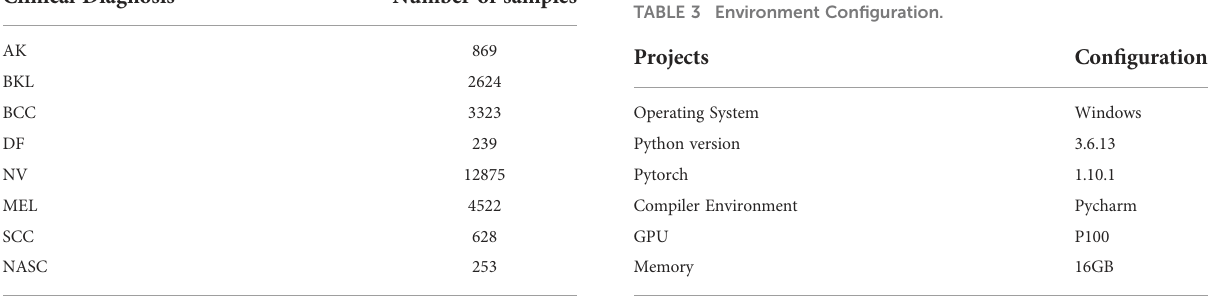
TABLE 3 Environment Con fi